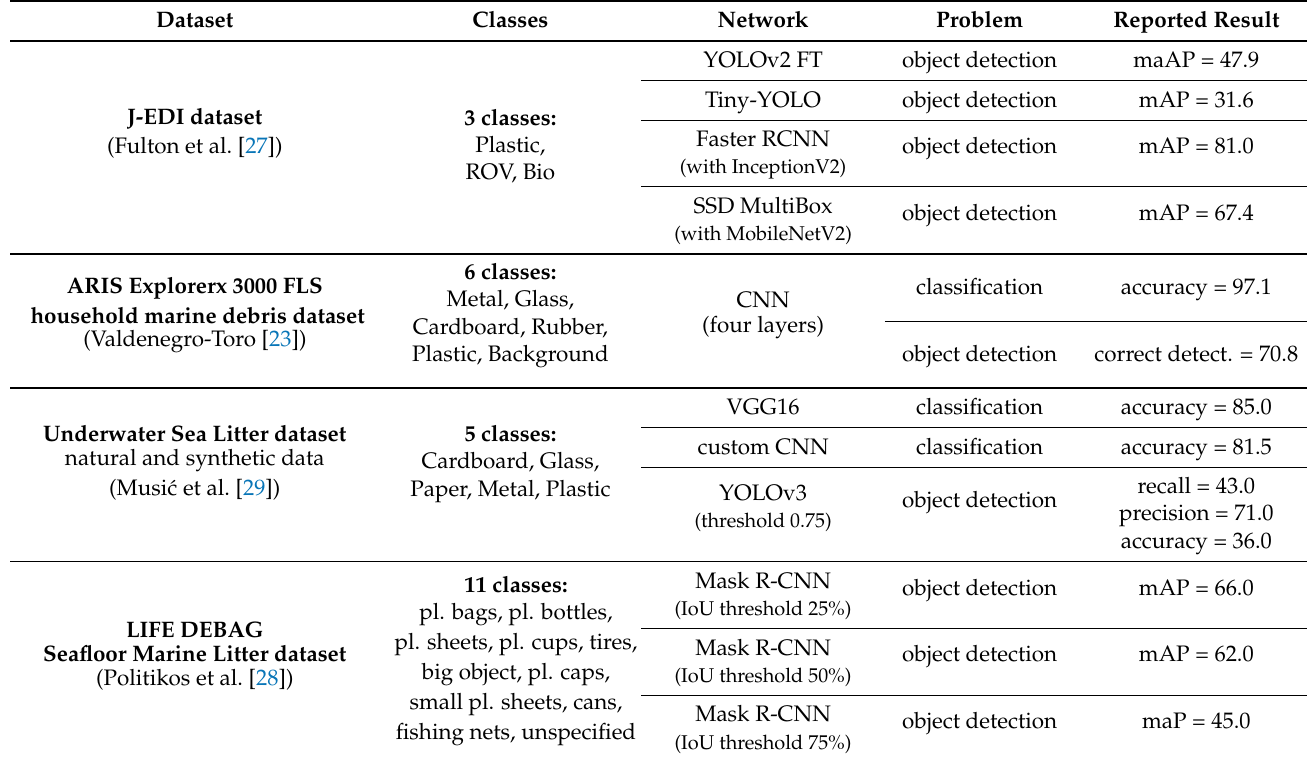
Table 7. Comparison of the performance of different approaches to the detection and classification of marine debris presented in the